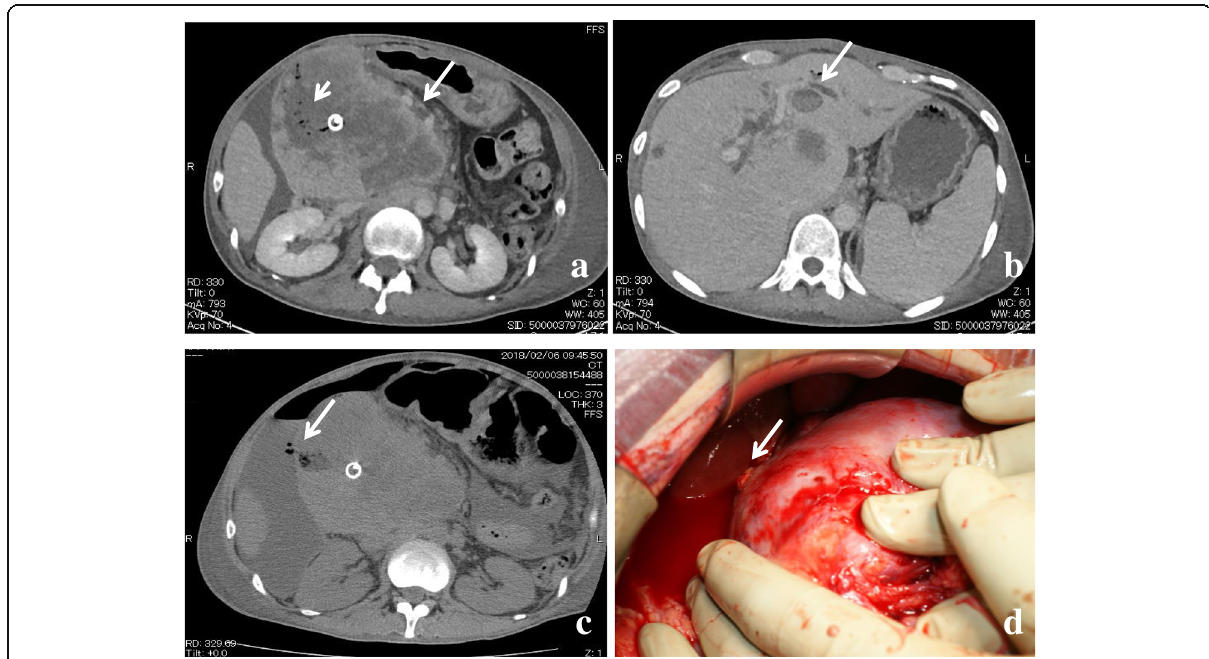
Fig. 2 a Dynamic CT after 5 cycles of chemotherapy. Lymph node metastasis spread (maximum diameter, 120 mm) (arrow). The duodenum was strongly depressed, and air was observed in the tumor (short arrow). b The size of the intraductal tumor at B2 did not change after the patient received chemotherapy (arrow). c Abdominal CT revealed ascites and continuous free air inside the abdominal tumor as lymph node metastasis in the hepatoduodenal ligament (arrow). d Intraoperative macroscopic findings. The ruptured tumor was observed in the hepatoduodenal ligament